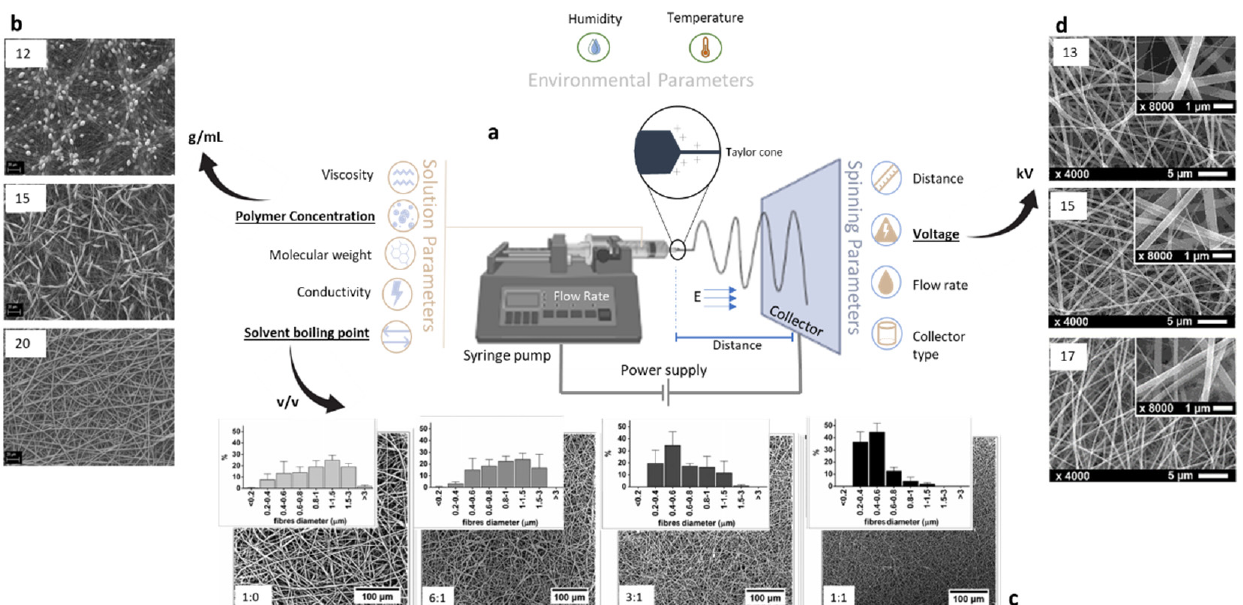
Figure 1. ( a ) Scheme of the basic electrospinning setup and influence of solution parameters: ( b ) Polymer concentration (SEM images of PCL fibers at different concentrations from [20]) and ( c ) solvent boiling point (SEM images and diameter size distribution of poly(trimethylene carbonate-co- ϵ -caprolactone) [P(TMC-CL)] nanofibers from [21]—spinning parameters: ( d ) applied voltage (SEM images of PVP/Cellulose Acetate/Garlic nanofibers(scale bar 5 µ m-int 1 µ m) from [22]. Two opposite forces contribute to forming the droplet: the electrostatic force acting on this droplet shape and the opposite force, the surface tension force, that tends to preserve the droplet’s spherical shape. At the point that the two forces have equilibrium, it is expressed by the following